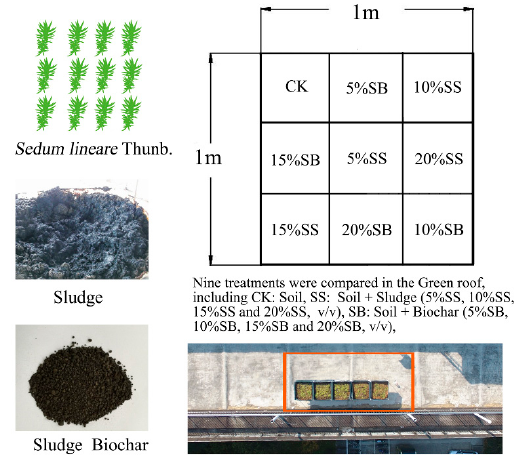
Figure 1. Schematic diagram of the roof’s layout.